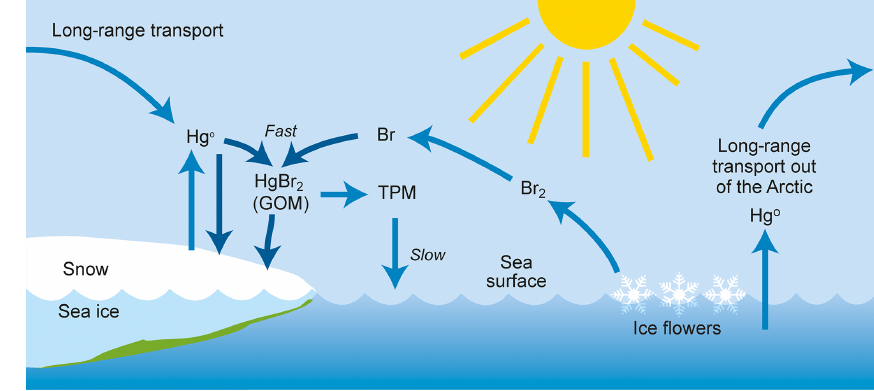
Figure 6. The mercury cycle in the Arctic atmosphere, where gaseous elemental mercury (Hg 0 ) is converted to gaseous oxidised mercury (GOM) that is quickly either deposited or converted into total particulate mercury (TPM). The chemical composition of GOM is unknown, and HgBr 2 is one suggestion among many.